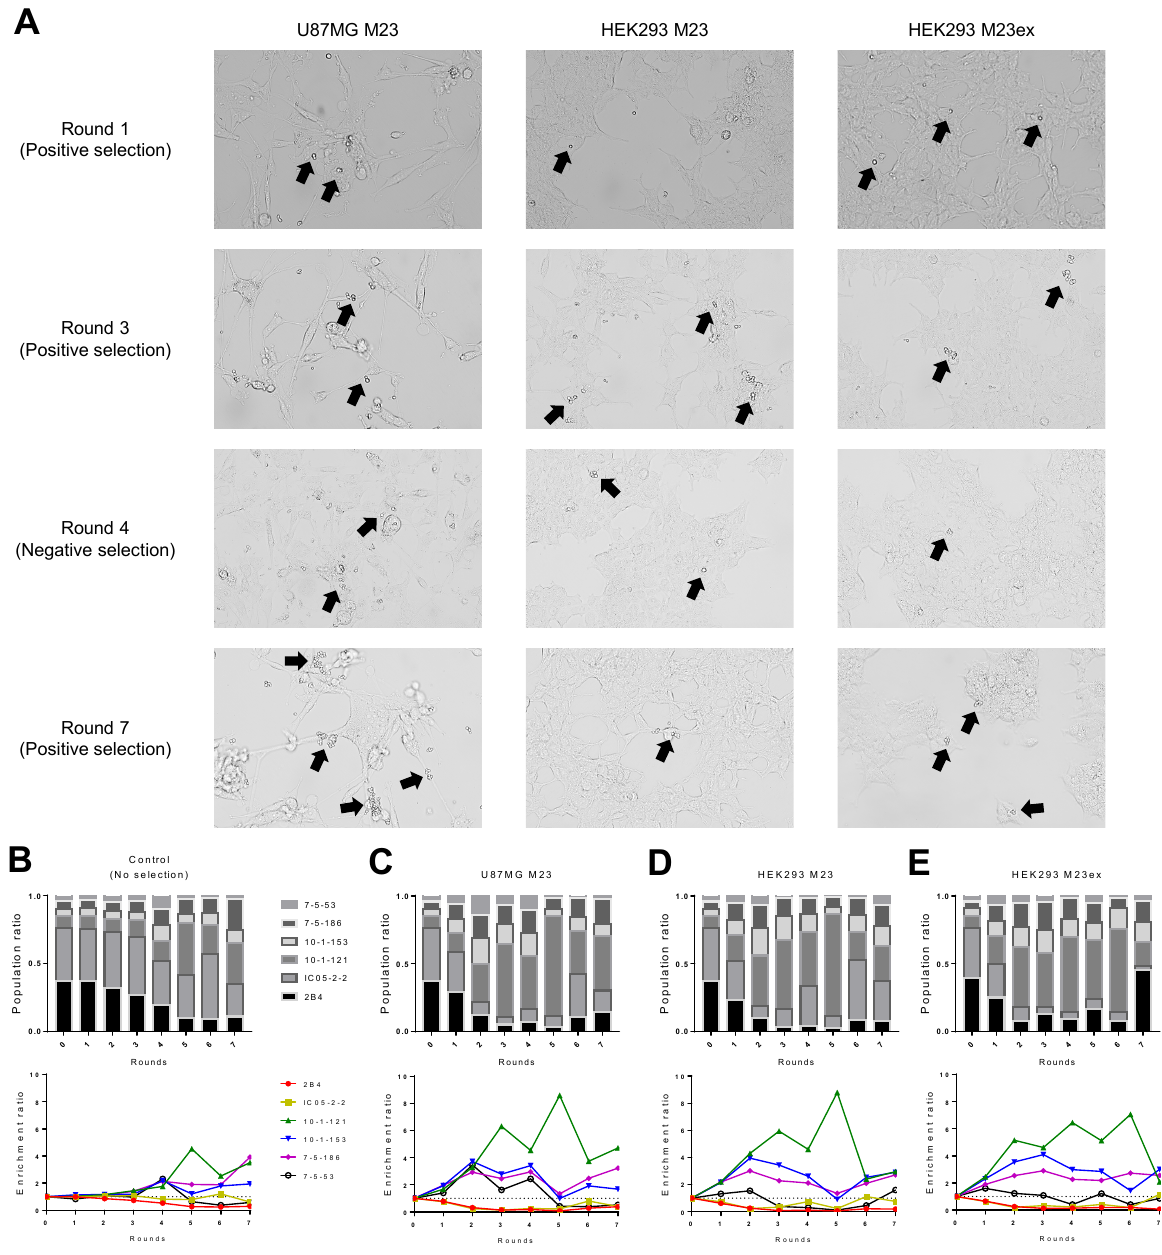
Figure 2. Cell-based biopanning results. ( A ) Representative brightfield images of biopanning after various rounds of selection. Black arrows show regions of yeast cells (small circular cells) binding to the adherent mammalian cells (large elongated cells). After each round of biopanning enrichment, NGS was performed to assess the population ratio and enrichment ratio for the ( B ) no selection control, and biopanning with ( C ) U87MG M23, ( D ) HEK293 M23, or ( E ) HEK293 M23ex adherent mammalian cells. For the no selection control, the yeast library was diluted without selection to monitor the natural drift of the